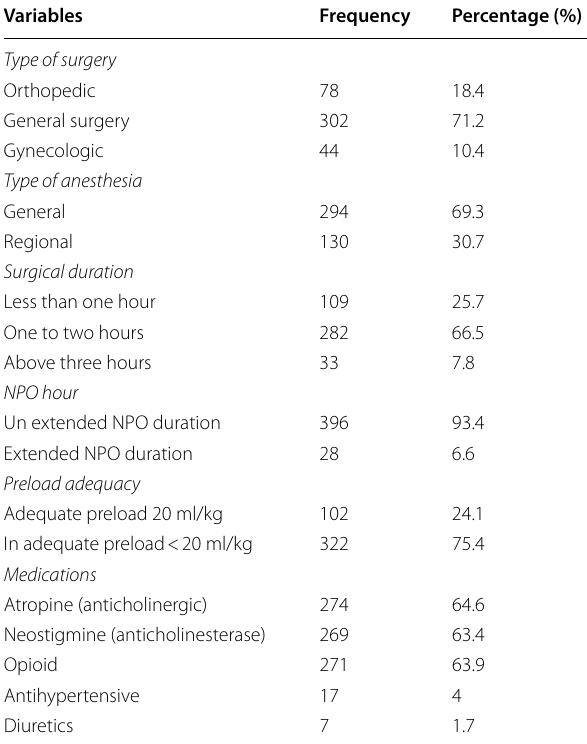
Table 3 Perioperative environmental and clinical factors for postoperative surgical patients (N =